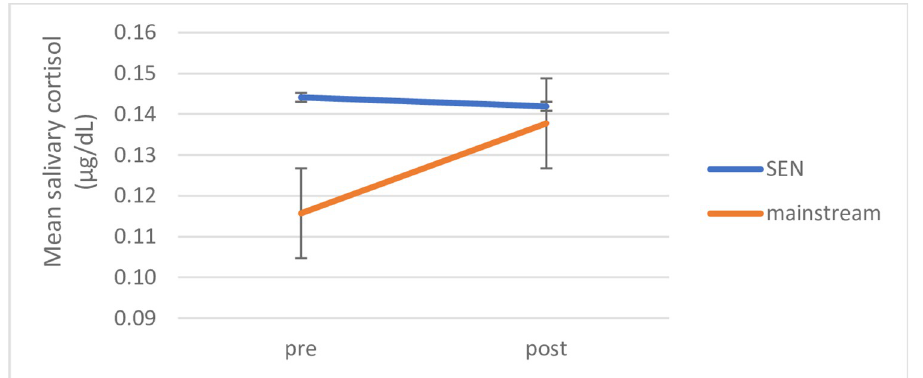
Fig 2. Significant cohort differences pre-post intervention. Differences between cohorts pre- to post intervention, figure shows mean salivary cortisol ( μ g/dL), error bars indicate standard error of mean.